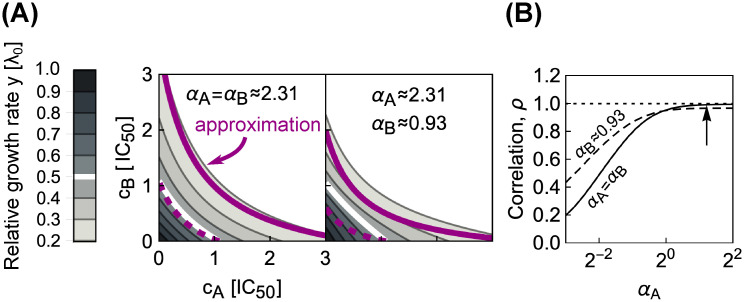
Combining antibiotics with shallow dose-response curves yields synergistic drug interactions.(A) Comparisons of numerically calculated dose-response surfaces and approximate solution. Purple isoboles (dashed and solid lines correspond to 50% and 20% relative growth rate, respectively) show the approximate solution on top of the dose-response surface calculated from the biophysical model (gray scale). Examples are shown for two pairs of antibiotics with identical (left) or different α (right). (B) Pearson correlation ρ between approximate and numerically calculated growth rate, evaluated for 121 × 121 equidistant concentration pairs. Solid and dashed line correspond to the cases with identical or different α, respectively. The correlation increases for antibiotics with higher α. The arrow shows α for the example on the left in (A).